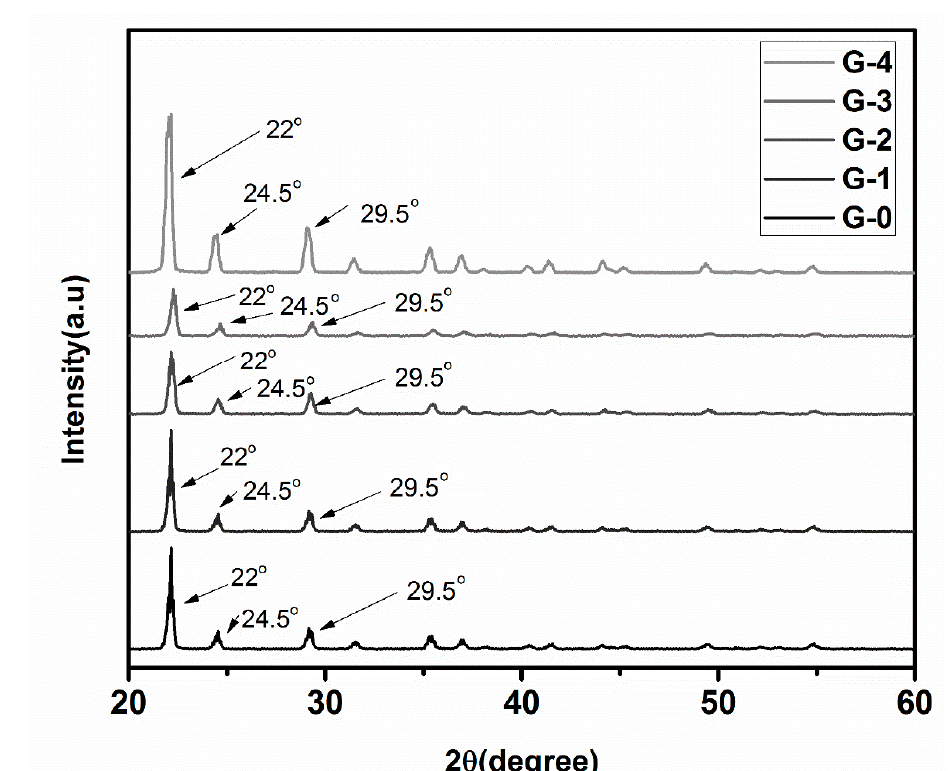
Figure 3. X-ray diffraction (XRD) pattern of uncoated and coated granular urea. Figure 3. X-ray di ff raction (XRD) spectrum of uncoated and coated